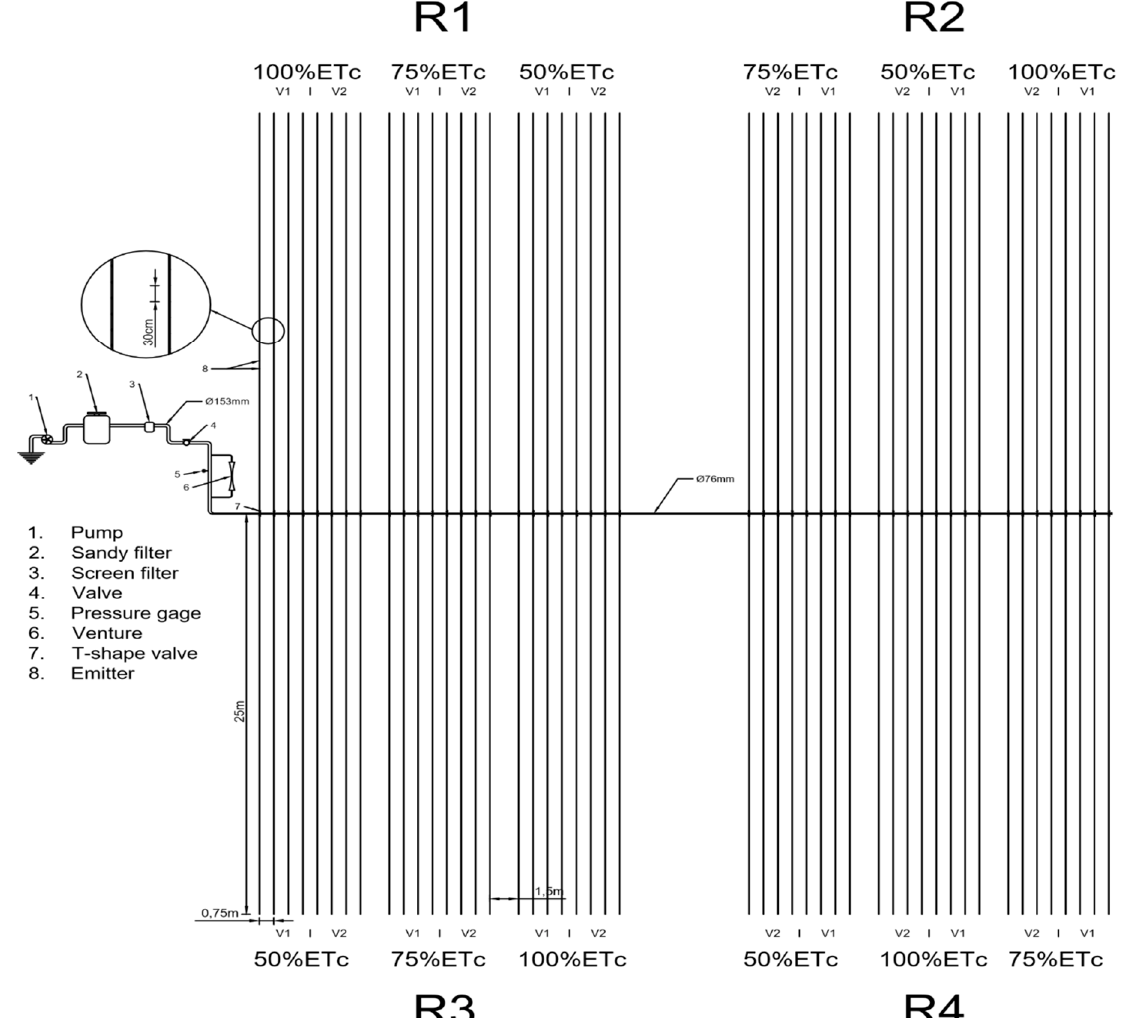
Figure 1. Schematic diagram of the experimental layout, which includes two potato varieties, three irrigation regimes, and four replications, showing locations of irrigation regimes and replications (R1, R2, R3, and R4). ETc indicates the estimated crop evapotranspiration. V1 and V2 indicate Arizona and Bellini varieties, respectively.